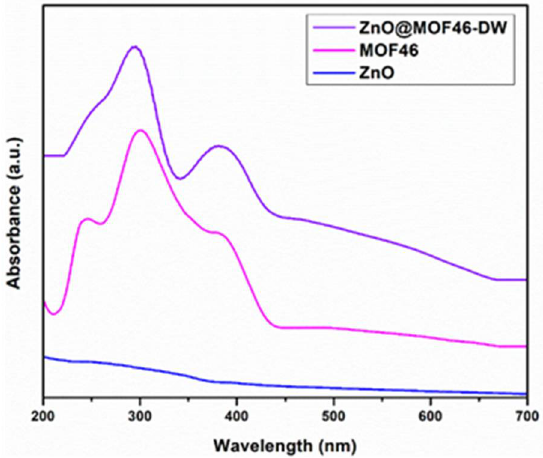
Figure 18. UV-vis absorption spectra of ZnO, MOF-46(Zn), and ZnO@MOF-46(Zn)-DW.